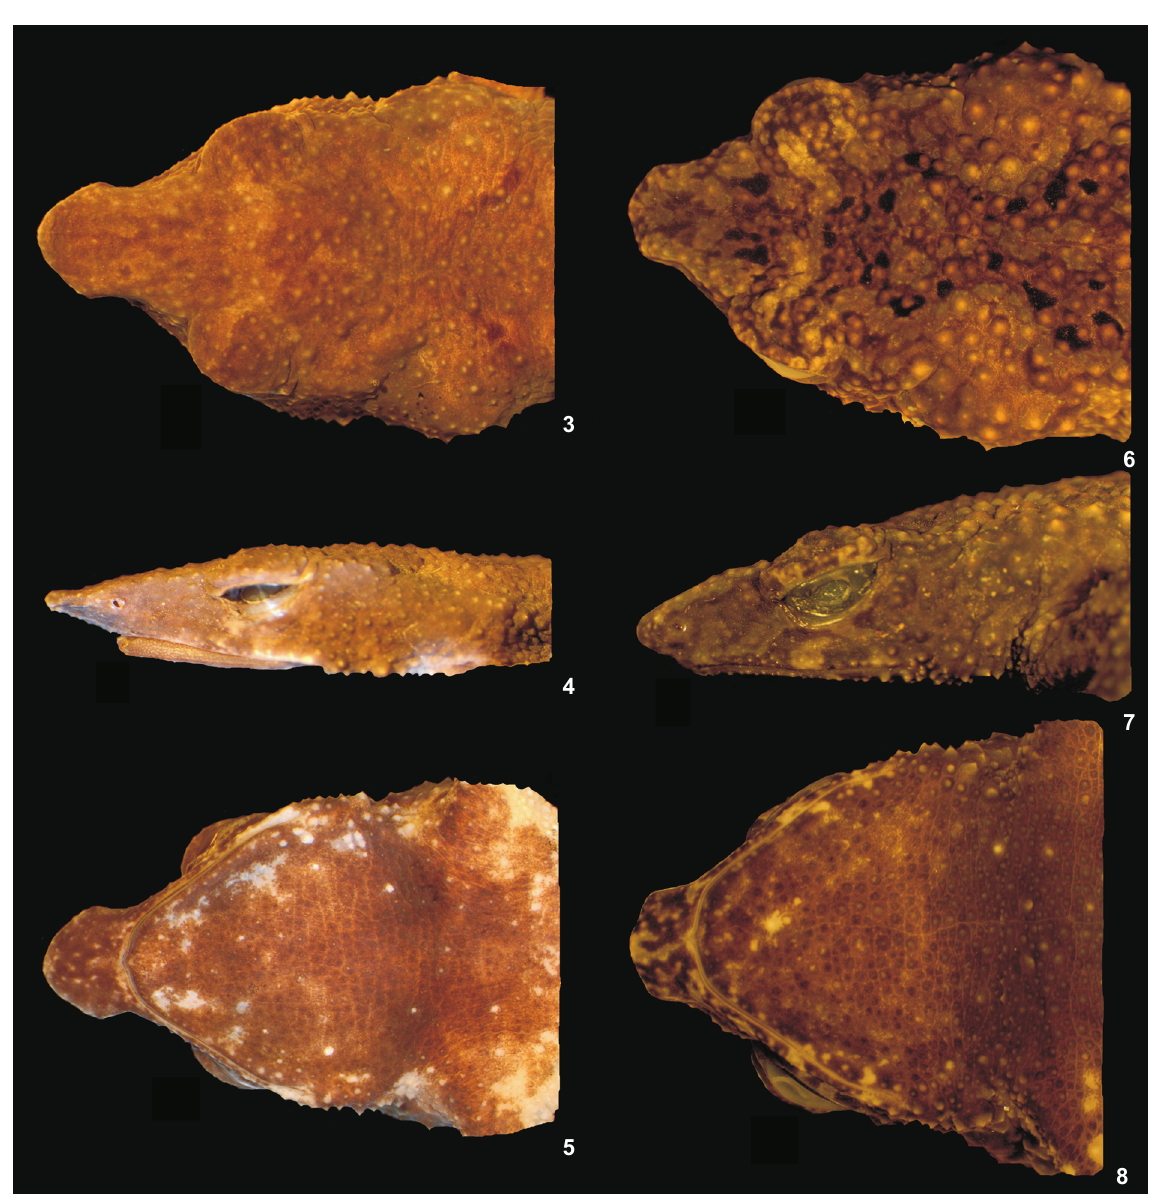
Figures 3-8. (3-5) Rhinella skuki sp. nov. , holotype, MNRJ 74619, SVL 26.2 mm: (3) dorsal view of head; (4) lateral view of head; (5) ventral view of head. (6-8) Rhinella boulengeri , UFBA 10086, SVL 27.8 mm: (6) dorsal view of head; (7) lateral view of head; (8) ventral view of lengths I<II<V<III<IV; toe tips rounded, slightly expanded; webbing absent; subarticular tubercles large, rounded; sole of foot with distinct, large rounded supernumerary tubercles; outer metatarsal tubercle small, rounded; inner metatarsal tubercle very large, elliptical, with the external border free; three rows of approximately aligned tubercles on the ventral surface of tarsus. Anal region not modified, rugose.